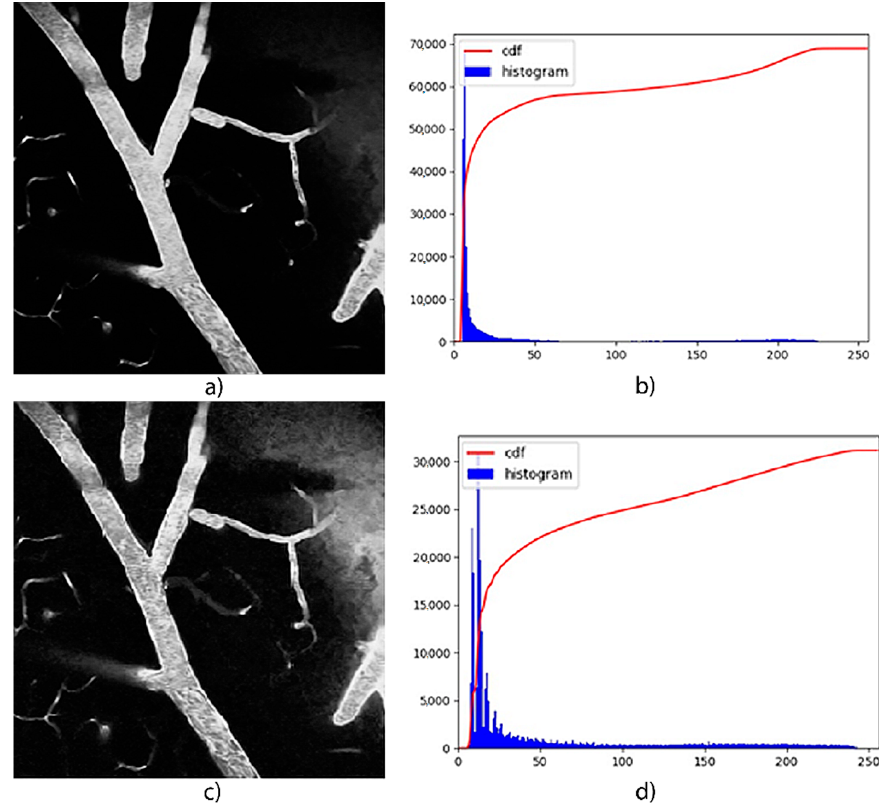
Figure 9. Comparison for a sample of the microscopy dataset [9] before and after histogram equalization. Image ( a ) and its histogram ( b ) correspond to the original data, whereas image ( c ) and its histogram ( d ) correspond to the enhanced by the CLAHE method [40]. Each histogram shows the distribution and the cumulative distribution function for the pixel intensity values present in its corresponding image. For the optimized image, the pixel values are slightly better distributed in comparison with the original image, which leads to a better classification of the blood vessels.